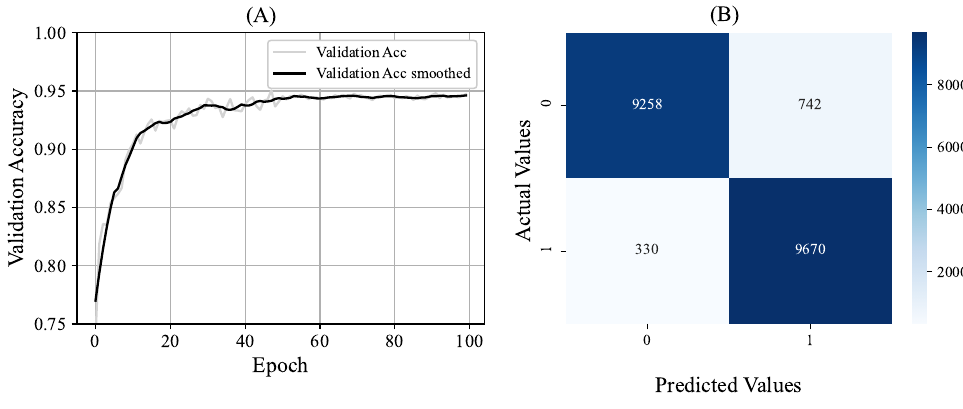
Figure 6. ( A ) The training loss vs. iteration; ( B ) the validation loss vs. epoch.